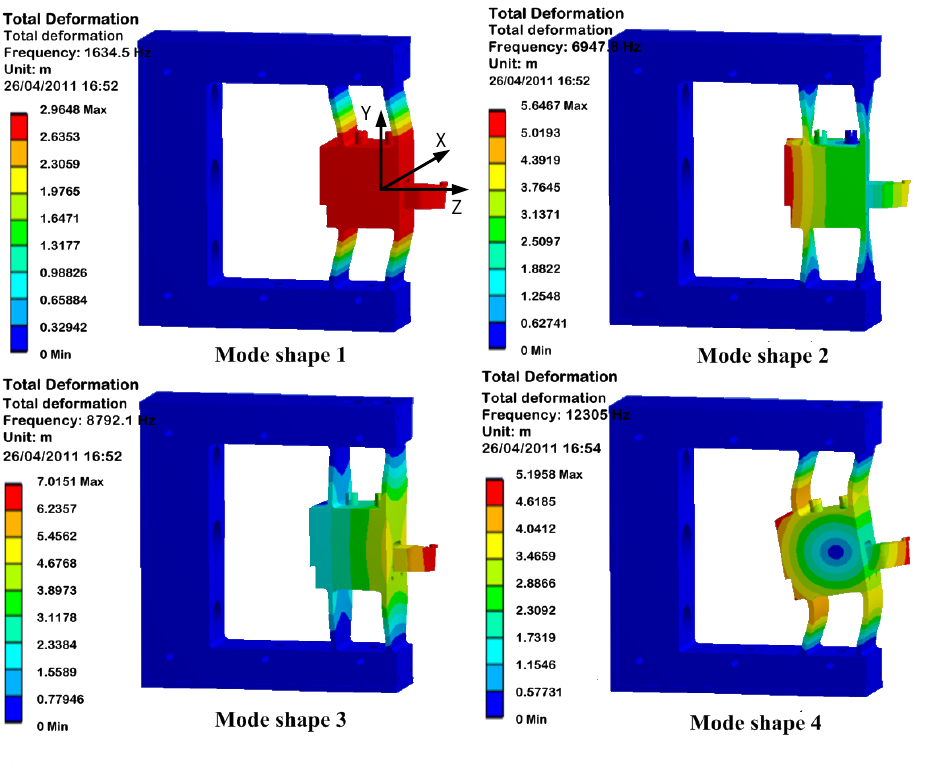
Figure 7. The first four natural frequencies and mode shapes. Figure 7: The first four natural frequencies and mode shapes